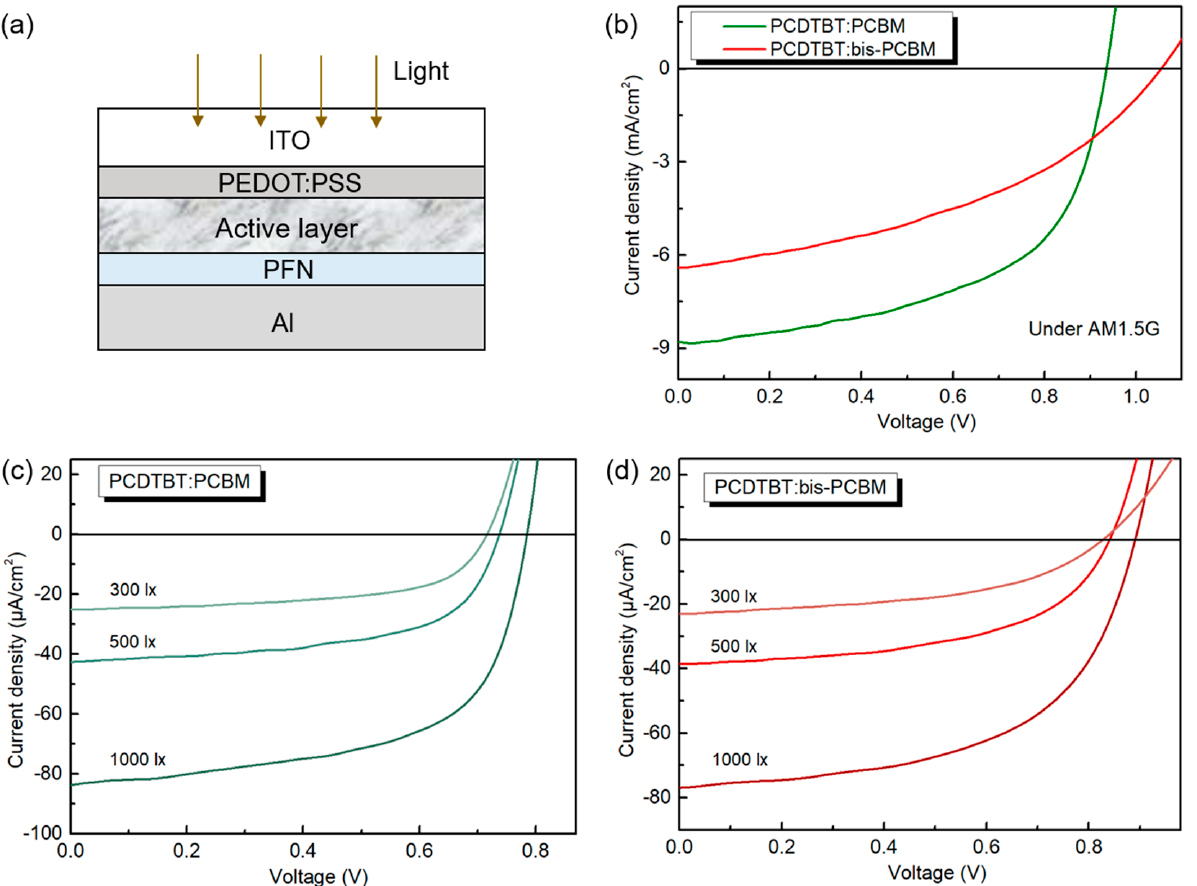
Figure 2. ( a ) Schematic diagram of the device structure. ( b – d ) J - V characteristics of the PCDTBT:PCBM and PCDTBT:bis-PCBM devices under AM 1.5G and indoor illuminations with the light intensity of 300 lx, 500 lx, and 1000 lx.